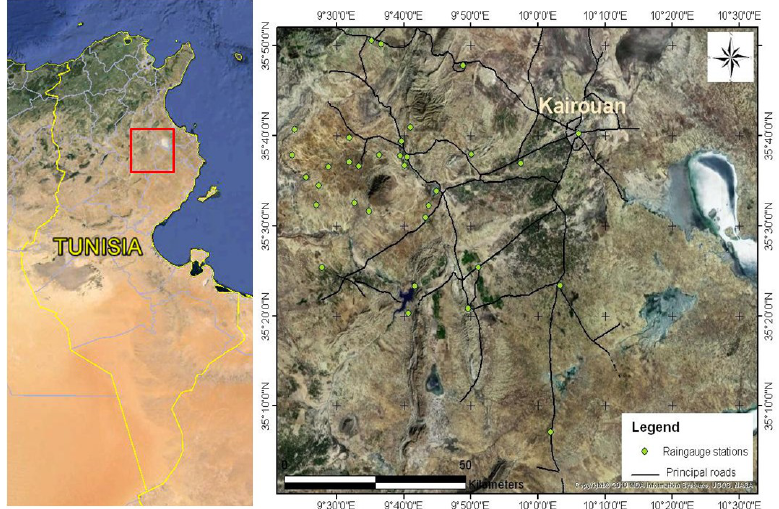
Figure 1. Satellite imagery of the studied area, indicating the locations of the rainfall and climate network stations present on the Kairouan